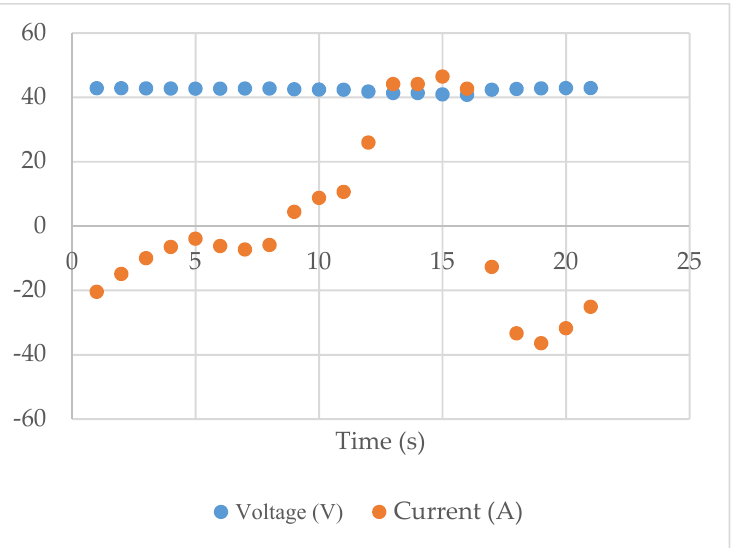
Figure 17. Battery pack voltage and current during the 100% throttle load cutoff test. The battery pack voltage successfully switches from discharge (positive) to recharge (negative).